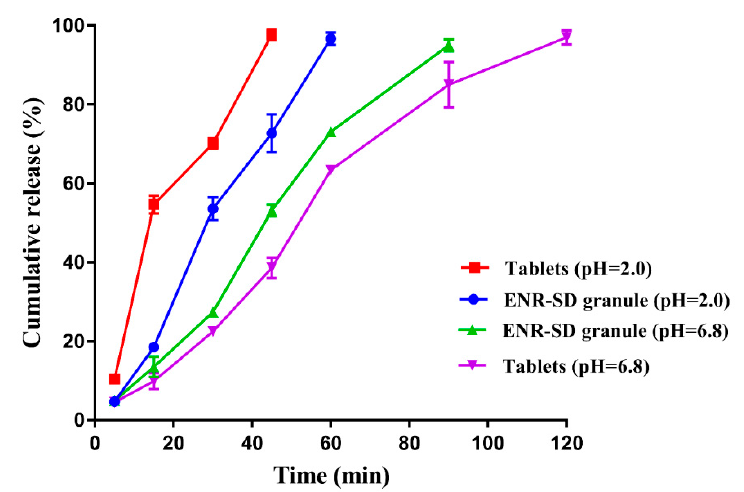
Figure 6. The in vitro release profiles of the commercial tablets and the ENR-SD granules in the SGF and the SIF. The ENR-SD granules showed a faster dissolution rate than that of commercial tablets in the SIF. Note: ENR-SD, enrofloxacin-loaded stearic acid solid dispersion.